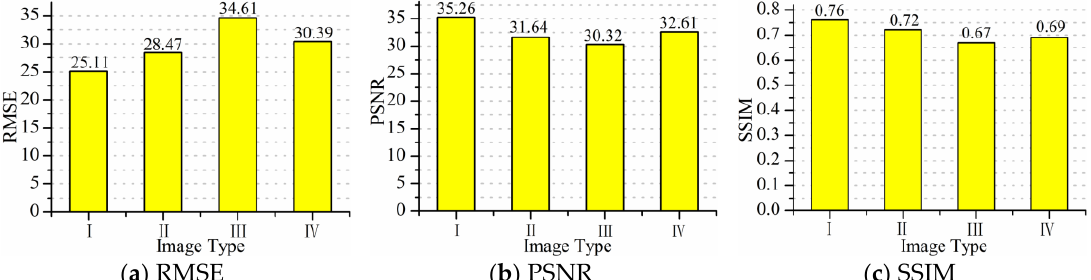
Figure 9. Evaluation results of label images. The three are the results of Root Mean Square Error (RMSE), Peak Signal to Noise Ratio (PSNR), and Structural Similarity (SSIM). Further, the I, II, III, and IV are four types of images.